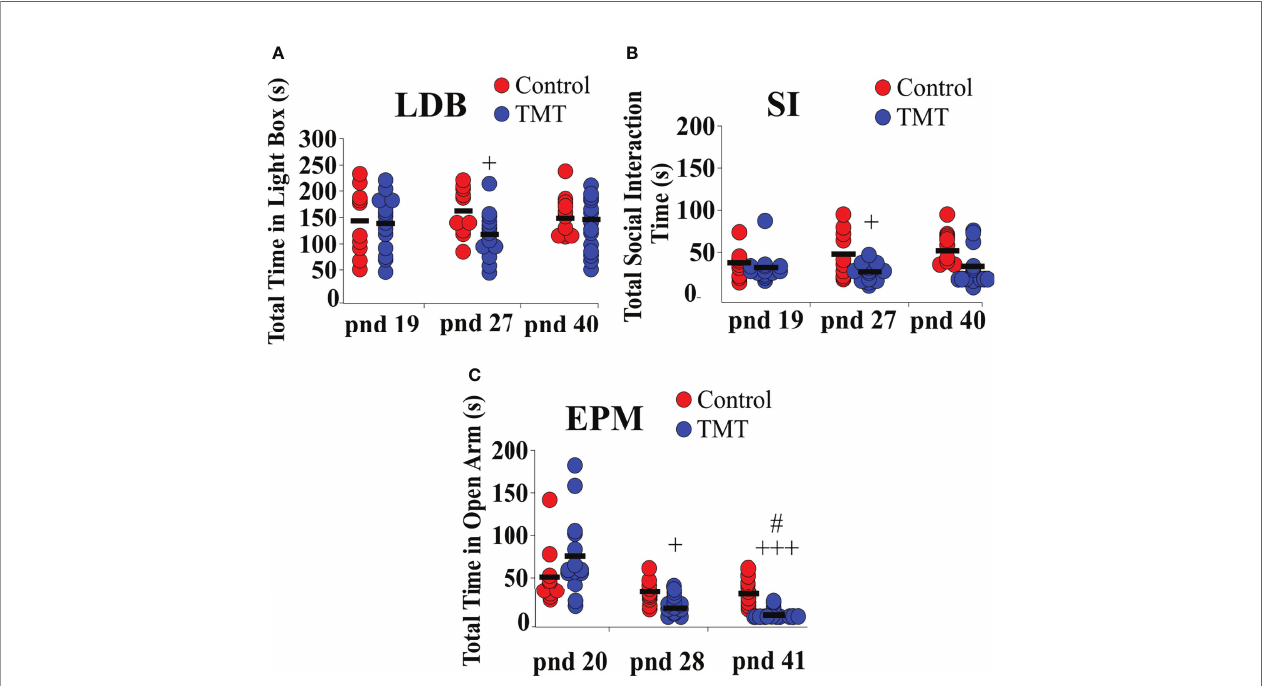
FIGURE 5 | Female C57Bl6/J mice chronically exposed to 2,4,5-Trimethylthiazole (TMT) showed increased anxiety-like behavior on the light-dark box (LDB) and elevated plus maze (EPM) and decreased social interaction with familiar conspeci fi cs on the social interaction (SI) test. (A) Summary of time spent in the light compartment of the LDB on post-natal day (pnd) 19 (before beginning of TMT-exposure), 27 (during TMT exposure) and 40 (after termination of TMT-exposure), (B) time spent socially interacting with familiar conspeci fi cs on pnd 19, 27 and 40, and (C) time spent in the open arm of the EPM on pnd 20, 28 and 41. LDB pnd 27, F (1,22) =5.75, +p<0.05; SI pnd 27, F (1,22) =8.52,+p<0.05; EPM pnd 28, F (1,22) =13.61, +p<0.05; EPM, F (1,22) =35.00, +++p<0.0001 on pnd 41 of control group (combined water control: n=6; ethyl vanillin control: n=4) vs TMT-exposed group (n=14); F (1,26) =5.65, #p<0.05 time spent in the open arm of the EPM in the TMT- exposed group on pnd 28 vs pnd 41.